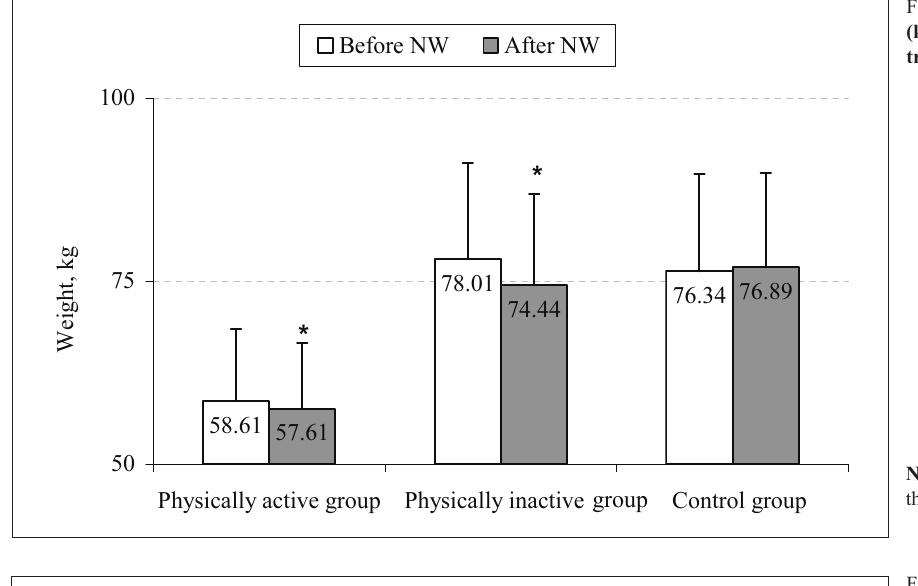
Figure 3. Obtaining the waist/ hip ratio before and after the Nordic Walking training